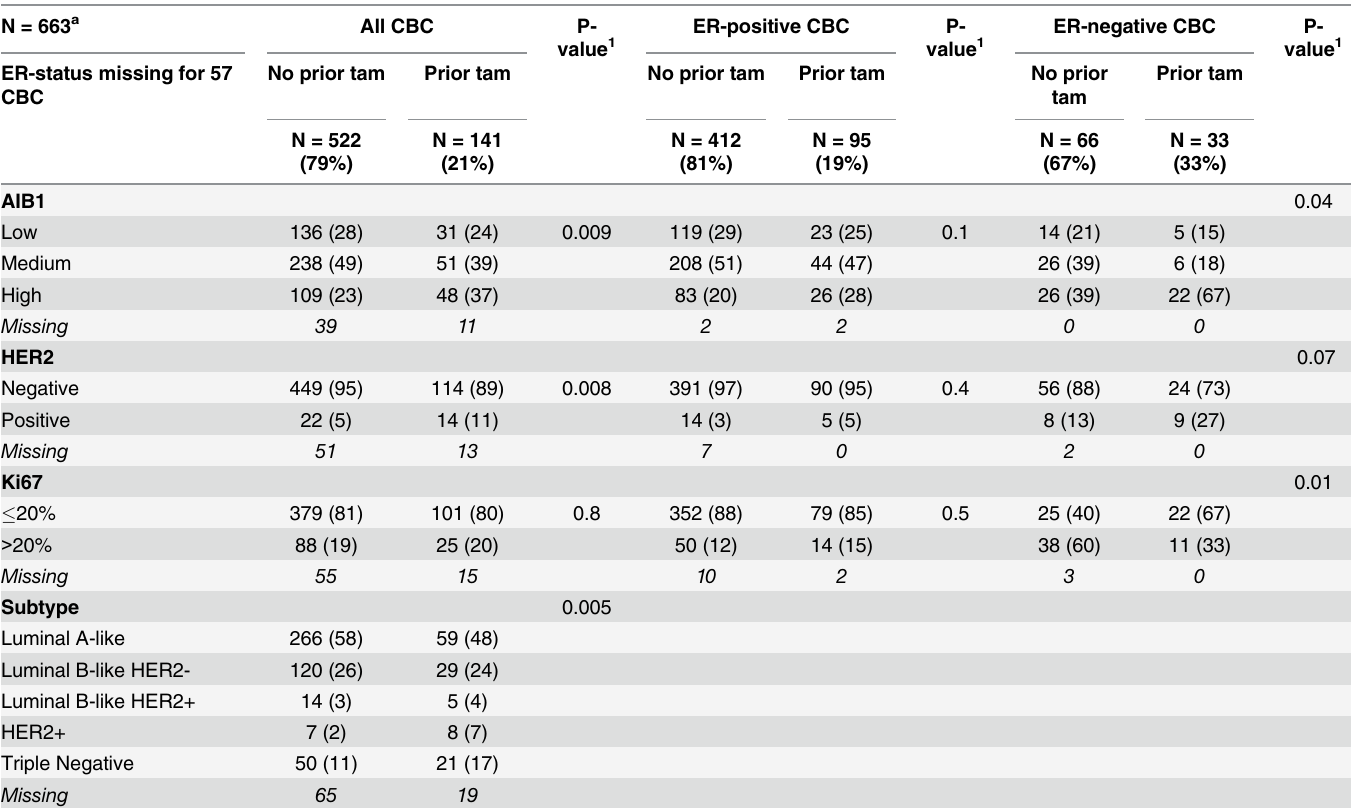
Table 2. Biomarkers in BC2 in relation to prior tamoxifen.